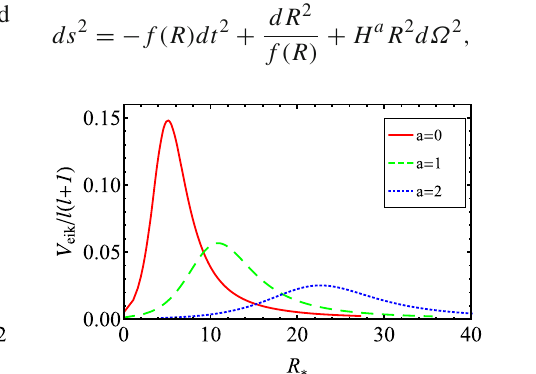
panels the solid red, dashed green and dotted blue curves correspond to a = 0, a = 1 and a = 2 cases, respectively. For numerical